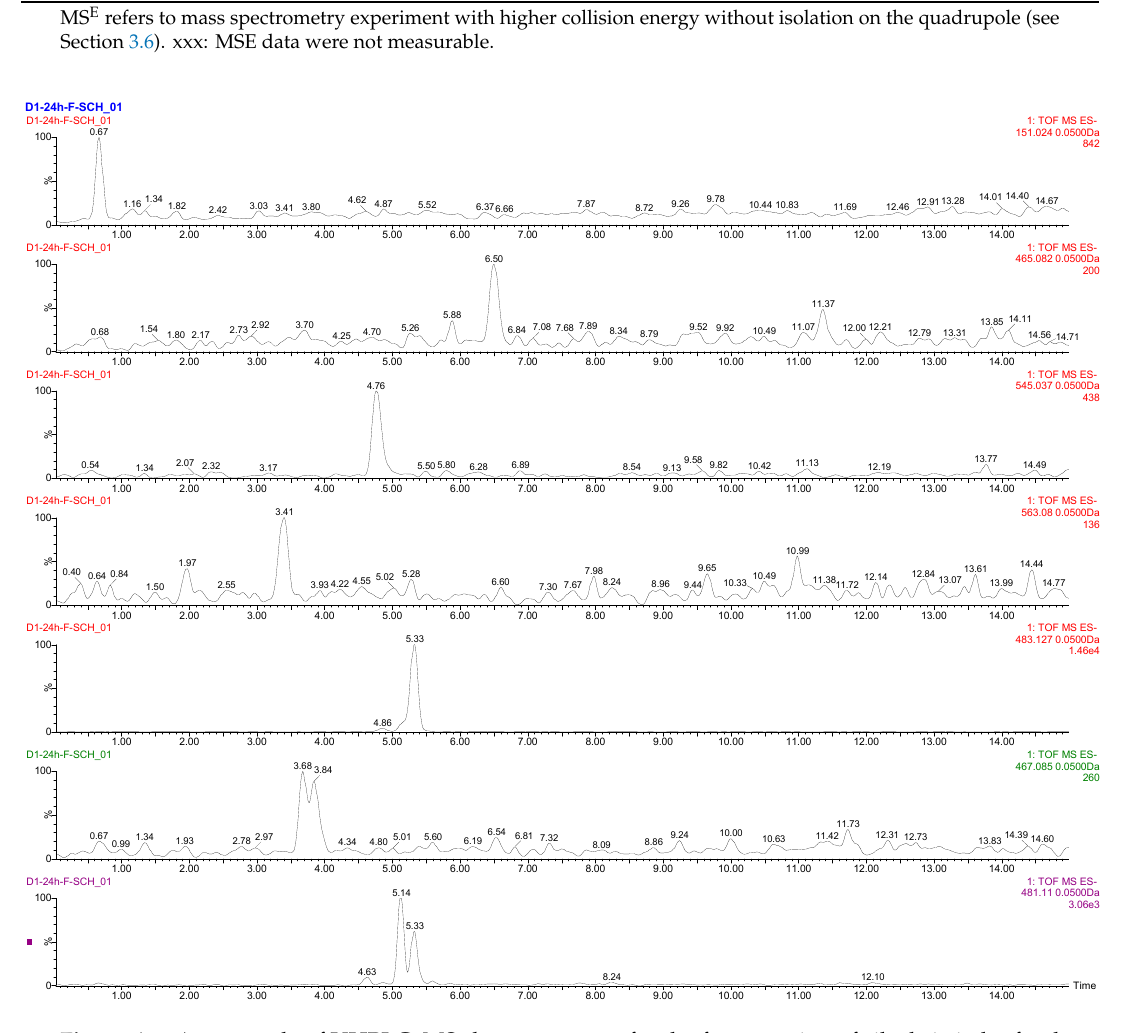
Figure A3. An example of UHPLC–MS chromatograms for the fermentation of silychristin by fecal microbiota from donor D4 for 24 h.